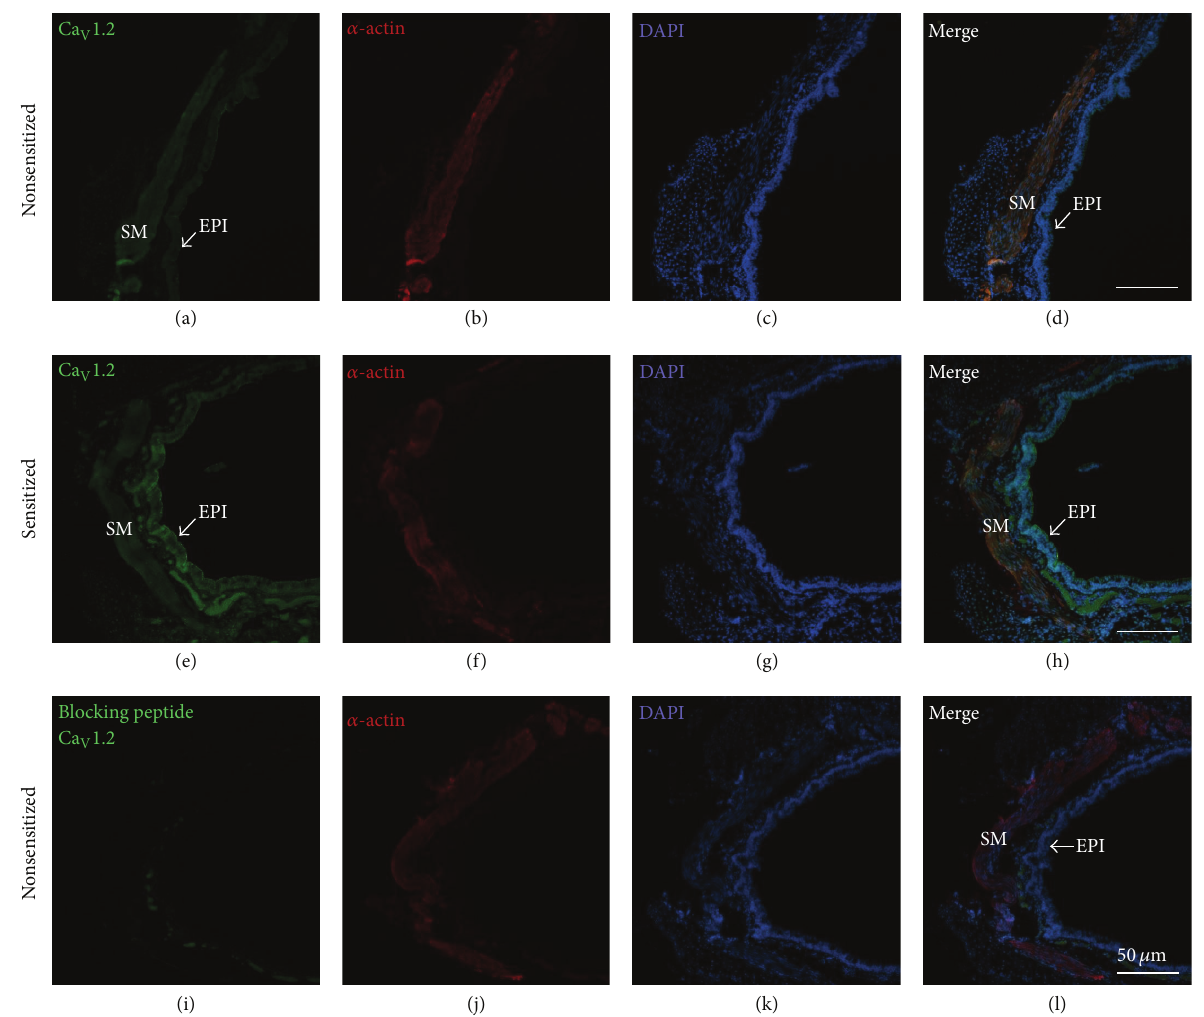
Figure 6: Immunofluorescence for Ca V 1.2 in nonsensitized and sensitized guinea pig tracheal smooth muscle. The first column shows immunoreactivity for Ca V 1.2 (stained green) in nonsensitized (a) and sensitized tissues (e); notice that Ca V 1.2 is located in the airway smooth muscle (SM) and epithelium (EPI, pointed by arrow); blocking peptide completely eliminated the fluorescence (i). The second and the third columns illustrate smooth muscle 𝛼 -actin (stained red; (b), (f), (j)) and cell nuclei (DAPI, stained blue; (c), (g), (k)). The last column depicts merged images of the former three columns ((d), (h), (l)). In these merged images, Ca V 1.2 is seen to be colocalized with 𝛼 -actin (stained yellow) on the smooth